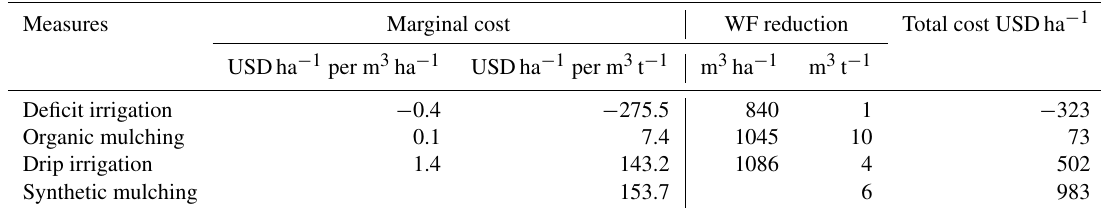
Table G4. Marginal cost and WF reduction per subsequent measure in the MCC for WF reduction in tomato production for the baseline of sprinkler irrigation combined with full irrigation and no mulching.